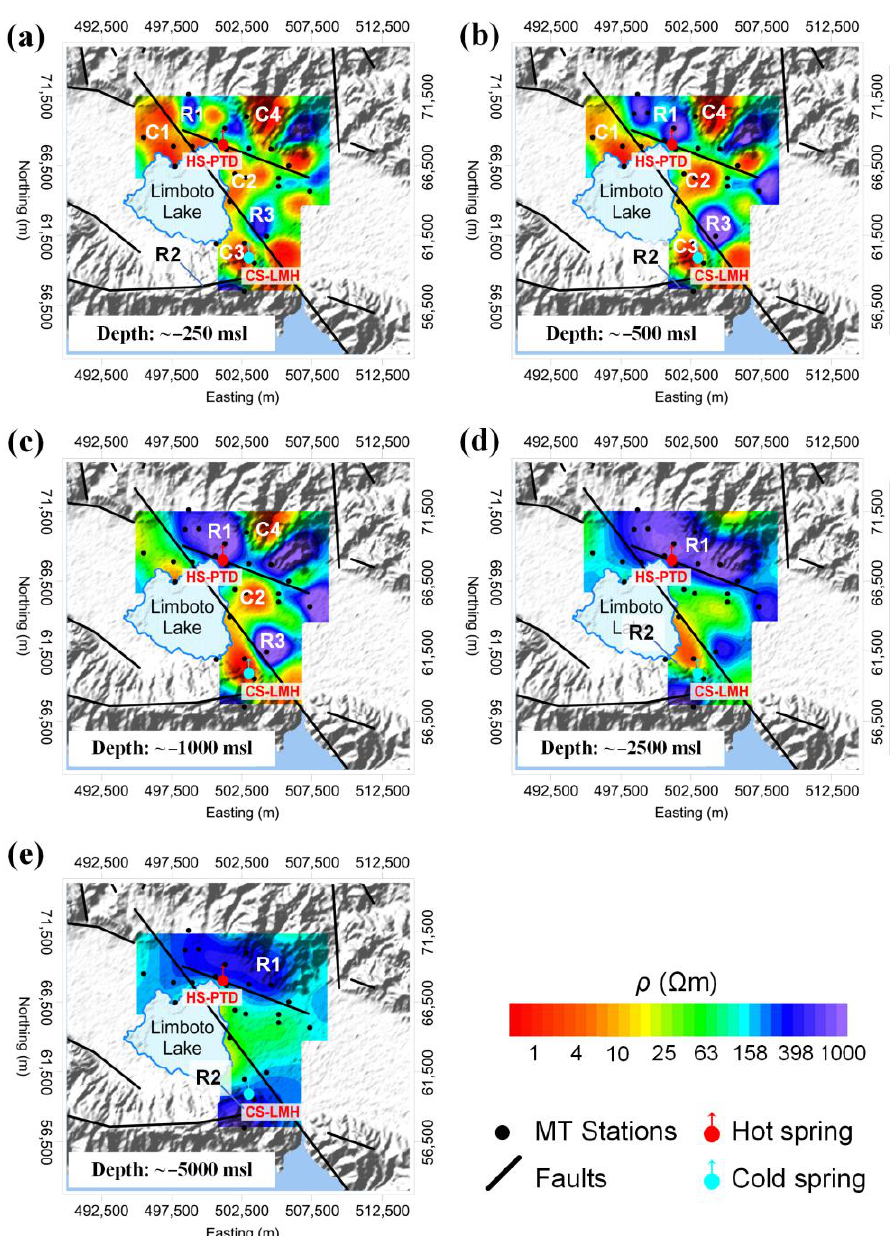
Figure 8. Plan views of resistivity distribution at depths from 0 msl to ~ − 5000 msl. Faults are plotted with solid lines. ( a ) Resistivity distribution at depth ~ – 250 km ( b ) Resistivity distribution at depth ~ – 500 km ( c ) Resistivity distribution at depth ~ – 1000 km ( d ) Resistivity distribution at depth ~ – 2500 km ( e ) Resistivity distribution at depth ~ – 5000 km.